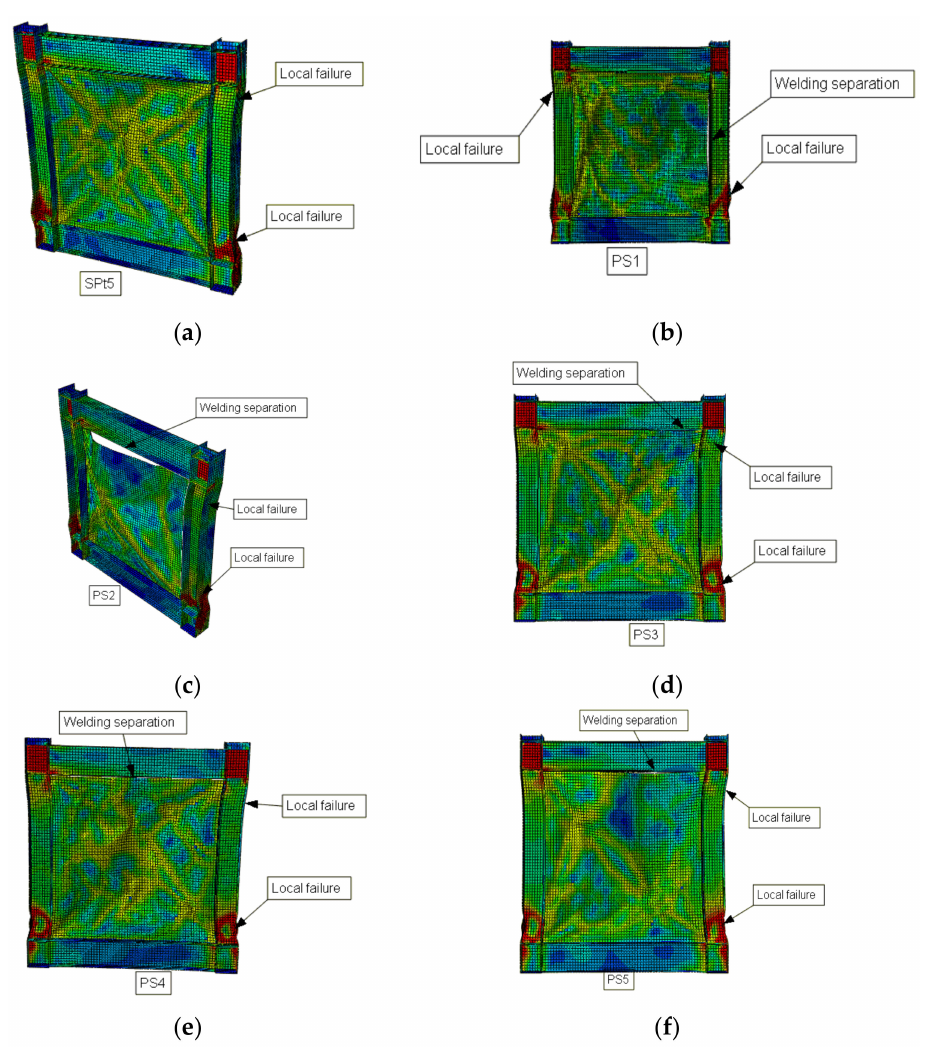
Figure 6. Failure modes: ( a ) SPt5; ( b ) PS1; ( c ) PS2; ( d ) PS3; ( e ) PS4; ( f )